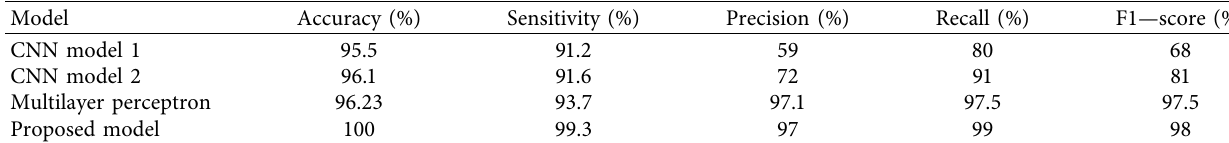
Table 1: Classification report.